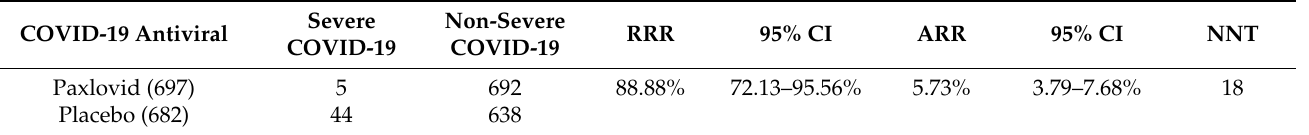
Table 2. Nirmatrelvir with ritonavir (paxlovid) EPIC-HR trial data to prevent severe COVID-19 in outpatients.